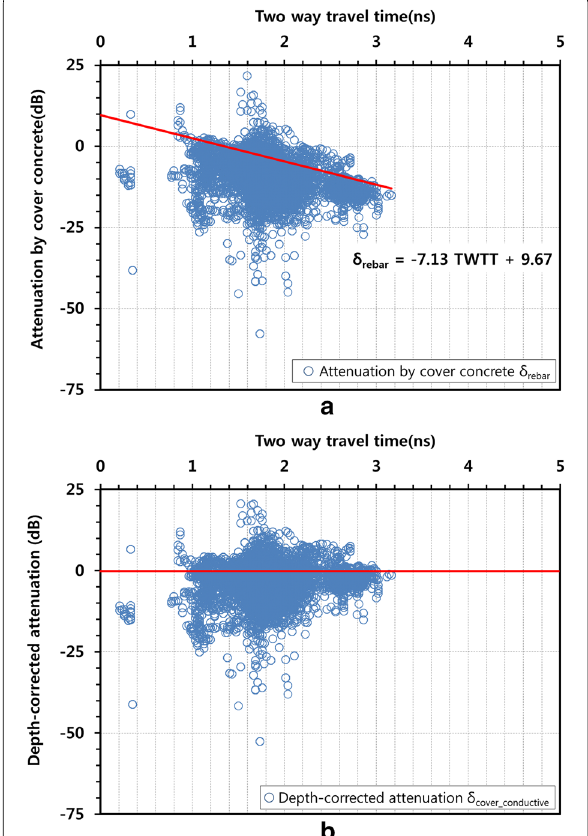
Fig. 13 The variation of attenuation of GPR reflected signal from rebars with TWTT: a before and b after the depth‑correction procedure.